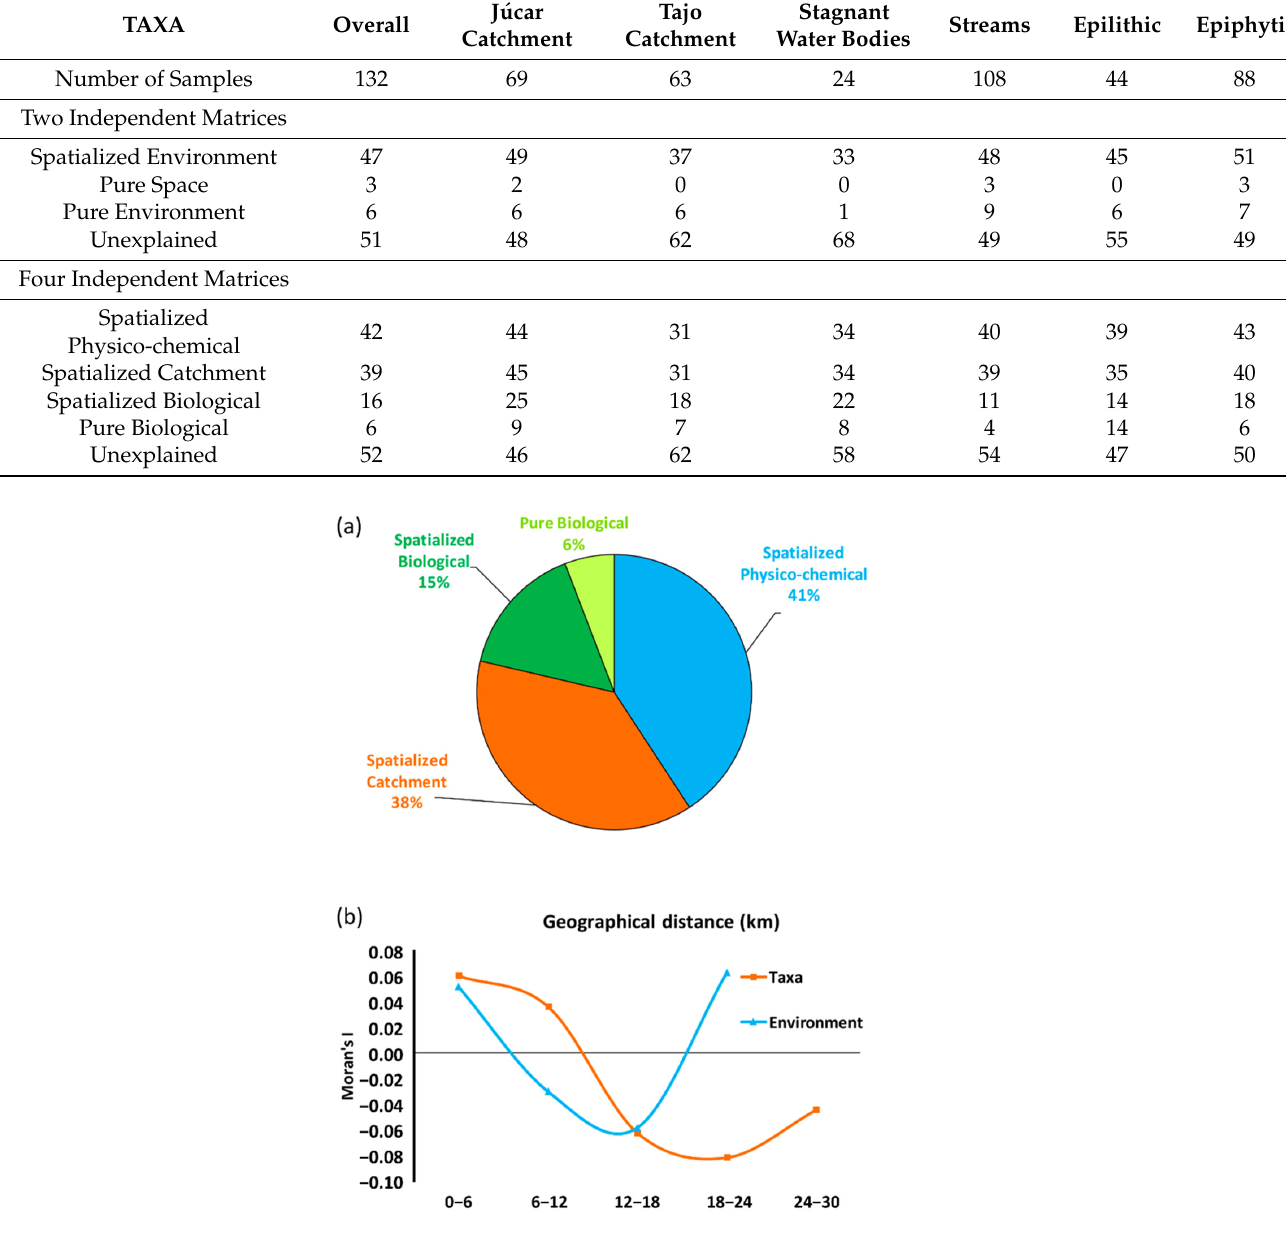
Figure 3. ( a ) Spatial and environmental (catchment, physico-chemical and biological matrices) contributions to BD metacommunity variability, calculated on relative abundance of taxa. Unexplained variance was 51%; the distribution of the variance explained is plotted. ( b ) Moran’s I spatial autocorrelation coefficients of the environmental and the relative abundance of BD taxa. Eight distance geographical classes (from 0 to 46 km, with each class being 6 km) were analyzed; only statistically significant coefficients at p < 0.05 are plotted.